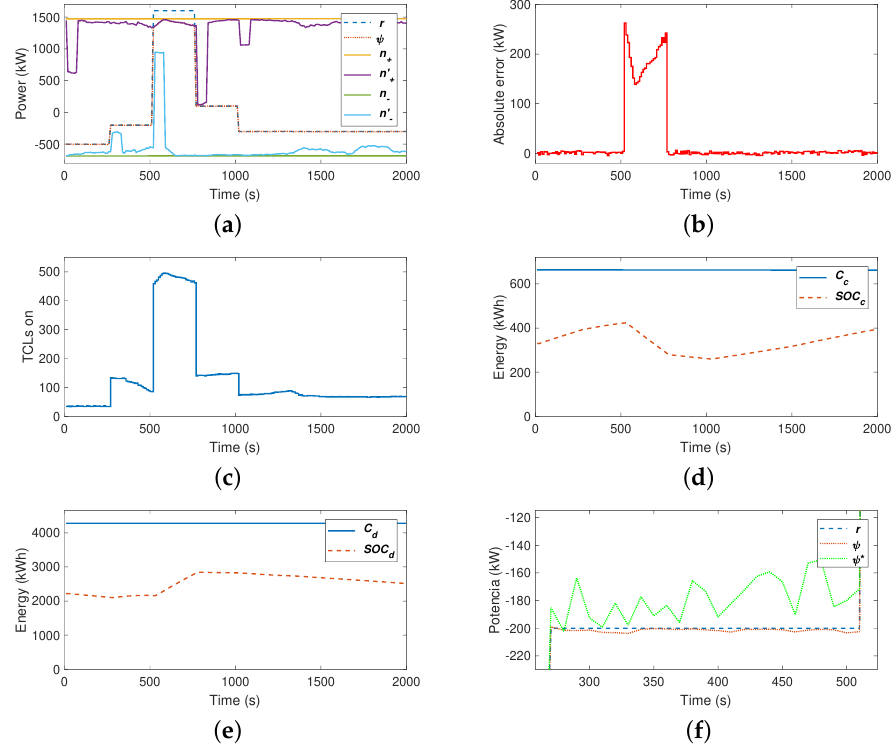
Figure 3. Results of the VB controller operation: ( a ) System operator signal and system deviation, ( b ) absolute error following operator signal, ( c ) number of TCLs on, ( d ) charging capacity and charging state of charge, ( e ) discharging capacity and discharging state of charge, and ( f ) system deviation comparison during instants between seconds